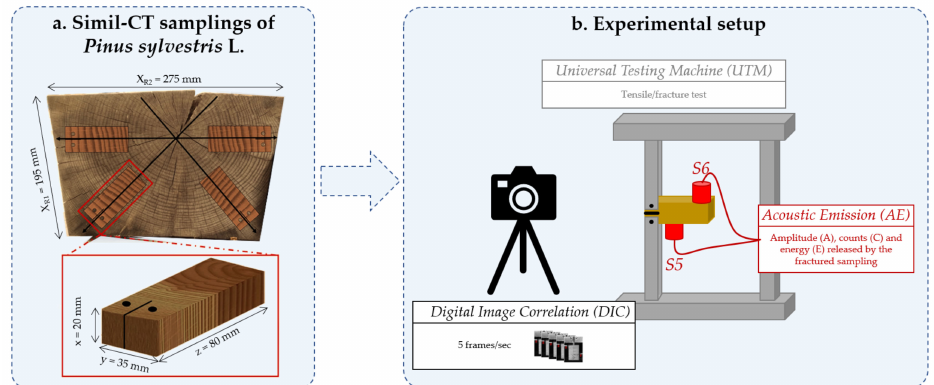
Figure 1. ( a ) Simil-CT samples cut from Scots pine ( Pinus sylvestris L.) beam, naturally dried out. ( b ) Experimental setup: universal testing machine (UTM) for tensile fracture tests, digital image correlation (DIC) for evaluating the elongation of the fracture, and two sensors, indicated by code S5 and S6, for the acoustic emissions (AE) to detect amplitude (A), counts (C), and energy (E) released by the